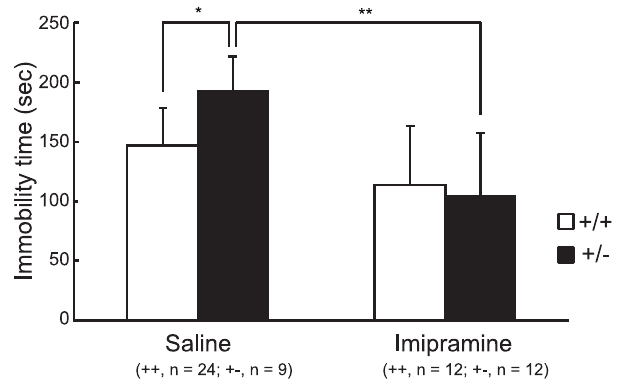
Figure 4. Effect of imipramine treatment on forced swimming. Immobility time of Pdlim5 hetero KO and wild-type mice in the forced swimming test with saline or chronic imipramine administration. Values are shown as mean 6 SD. * p , 0.05 and ** p , 0.01 by ANOVA.